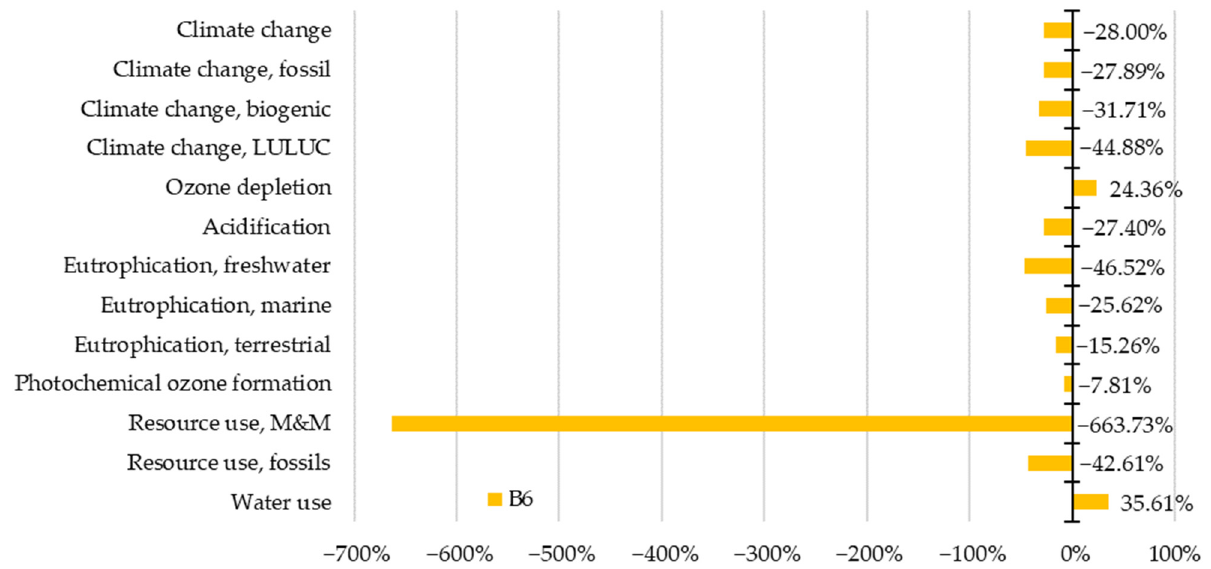
Figure 5. Environmental impact shift of the B6 stage considering photovoltaic energy storage.